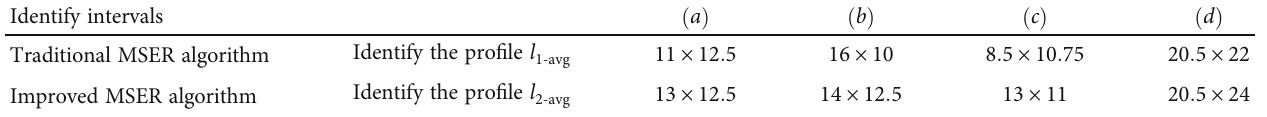
Table 4: Recognition area median contour table before and after